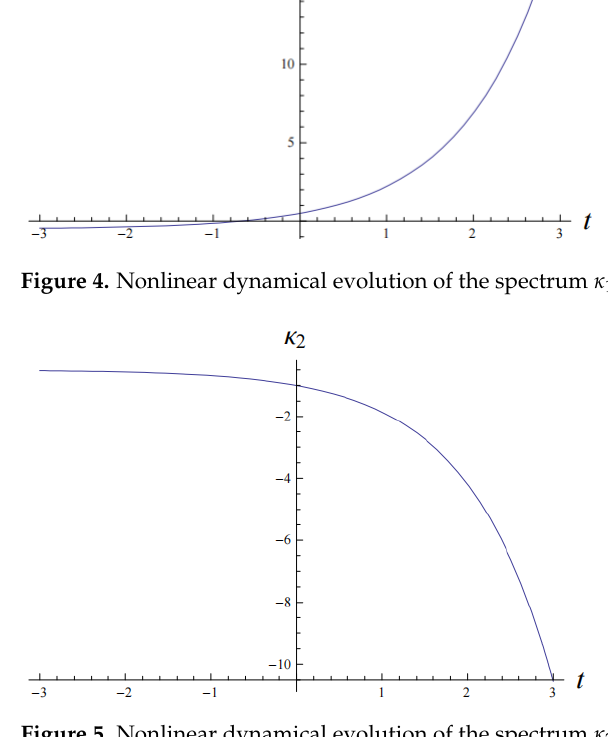
Figure 5. Nonlinear dynamical evolution of the spectrum κ 2 in Equation (123).